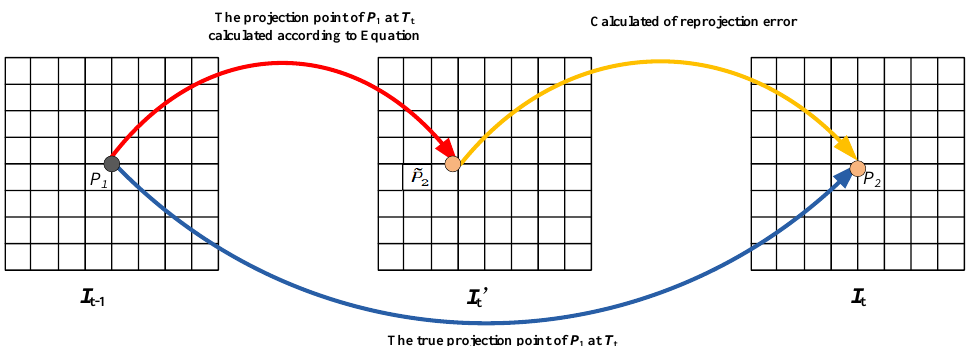
Figure 2. The reprojection error of two adjacent frames. P 2 is the true projection point of P 1 at T t , 𝑃̃ 2 is the projection point of P 1 at T t calculated according to Equation (4). The reprojection error of P 1 at T t can be expressed as: ||𝑃 2 − 𝑃̃ 2 || .